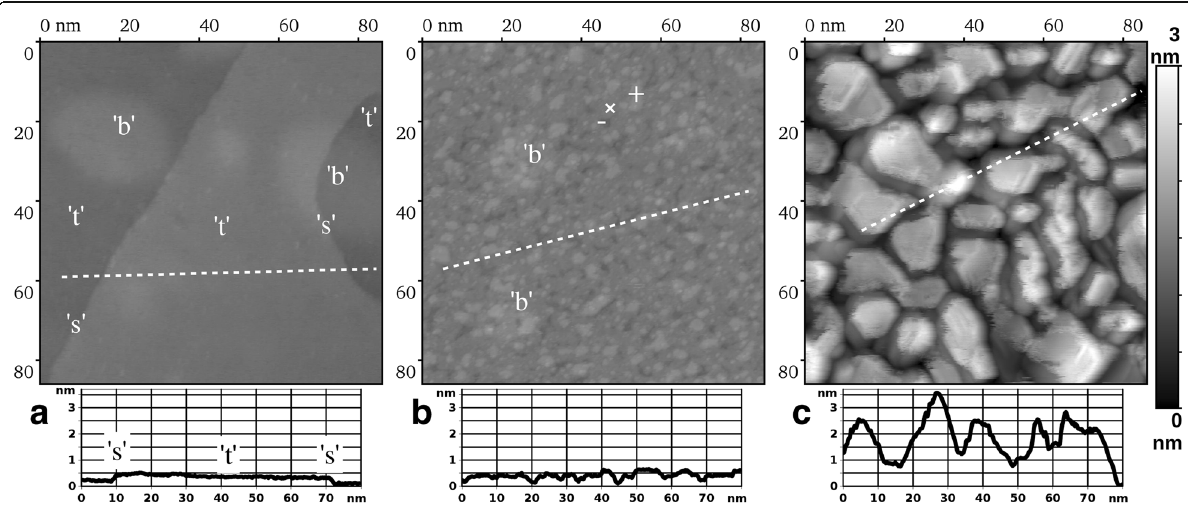
Fig. 1 STM images (86 nm × 86 nm) of the single-crystal Ru(0001) sample at different stages of Au film growth: a the initial clean metallic substrate; sample bias voltage: U = + 0.1 V, tunneling current: I = 10 nA. b 5 ML Au film; U = − 0.05 V, I = 1 nA. c 9 ML Au film; U = 0.01 V, I = 1 nA. All images are presented in an identical gray scale (height-to-color correspondence), which is given rightmost. The height-distance cross-sections along the dashed lines are presented below every image. The meaning of designations within the images: “ t ” — atomically flat terraces, “ s ” — single atomic steps, “ b ” — locations above the buried argon bubbles, “ × ” — height level of the atomic layer corresponding to nominal coverage, “ − ” — one atomic layer below the nominal, “ + ” — one atomic layer above the